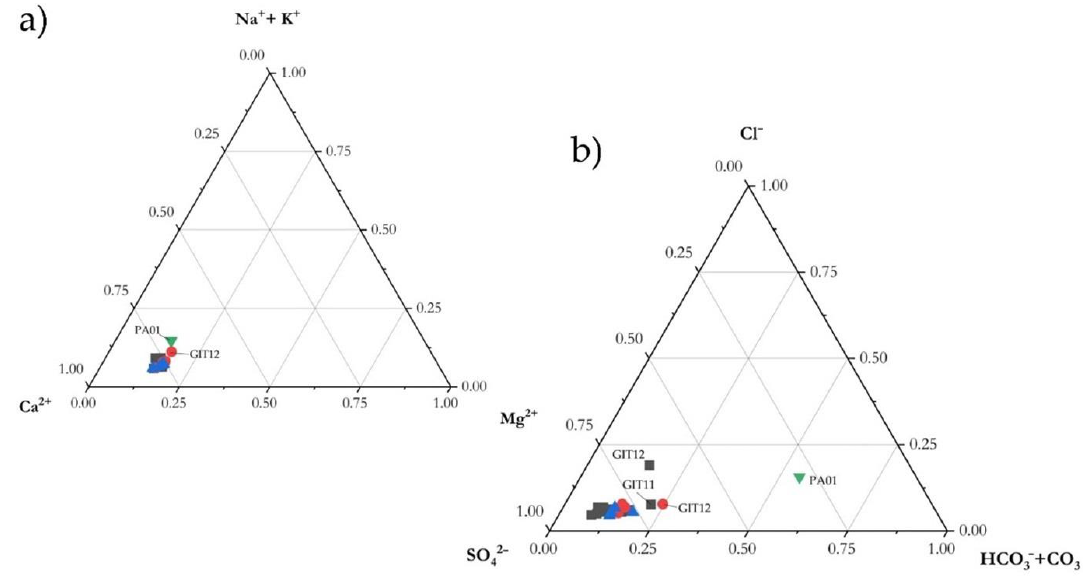
Figure 3. Cationic (a) and anionic (b) triangular diagrams of the studied waters (FdC sampling: